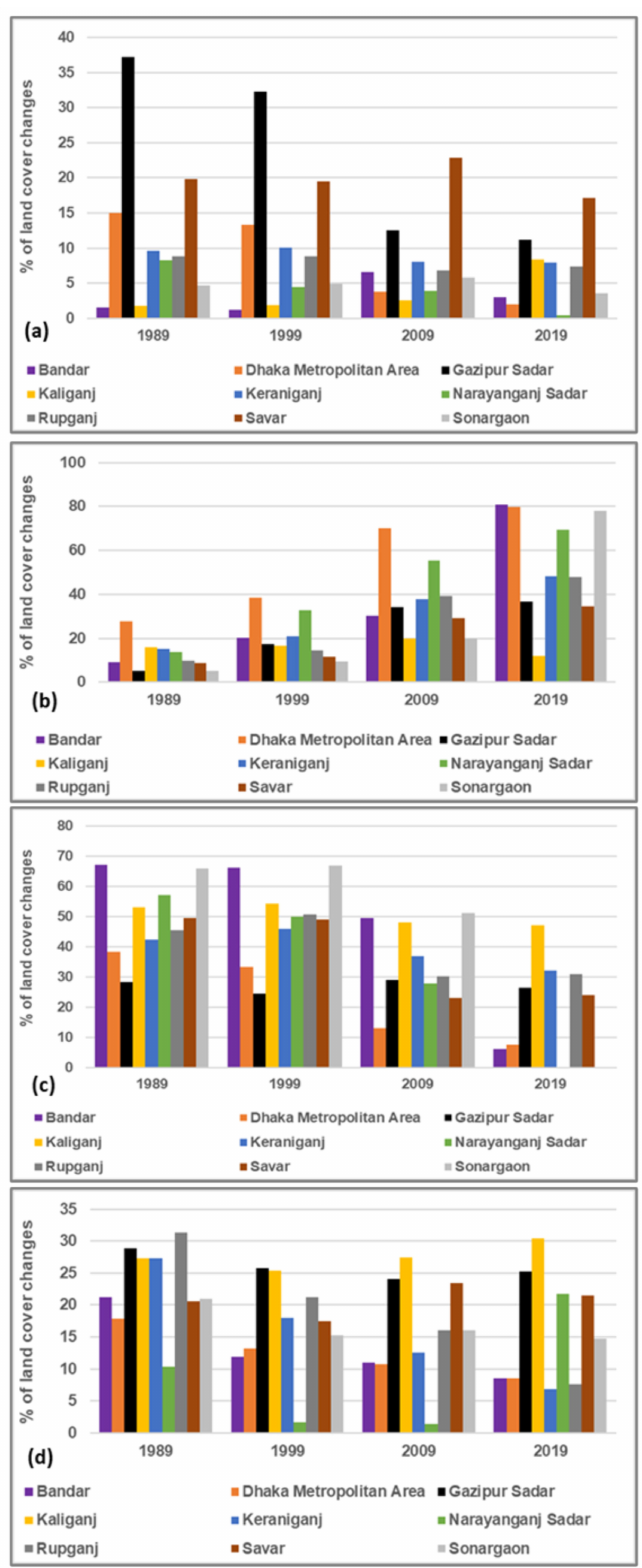
Figure 7. ( a ) % of net changes in bare soil; ( b ) % of net changes in built-up areas; ( c ) % of net changes in vegetation; ( d ) % of net changes in low-land